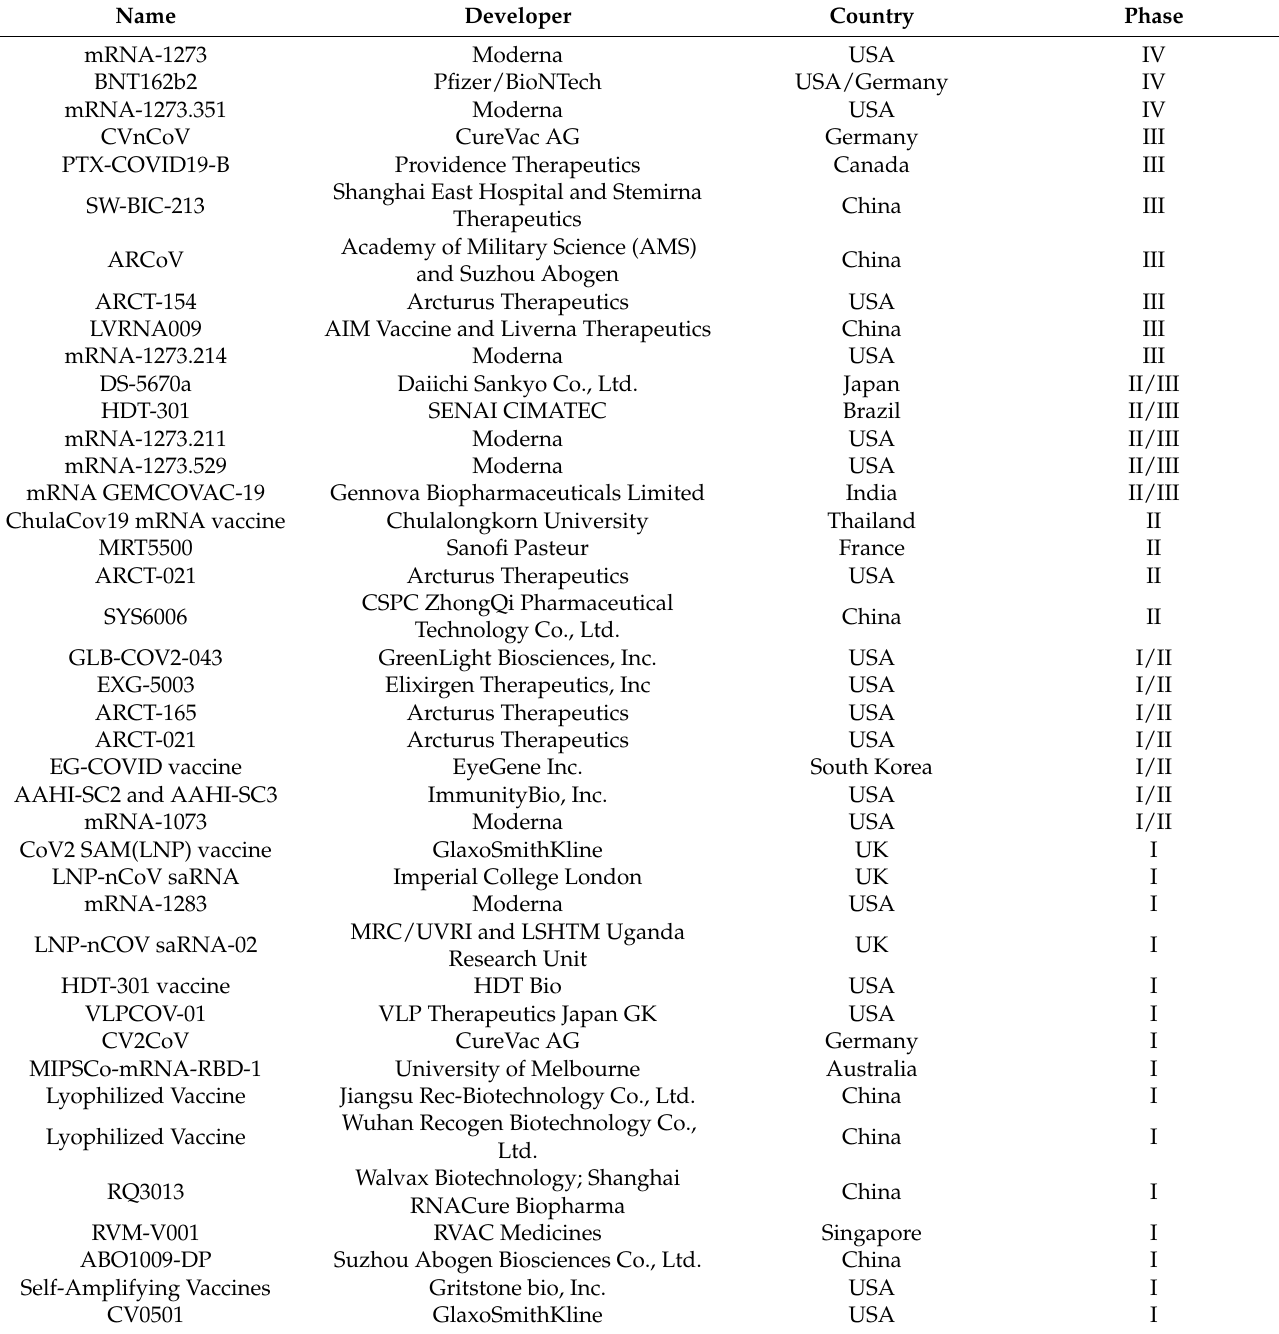
Table 2. Clinical trials of COVID-19 mRNA vaccines